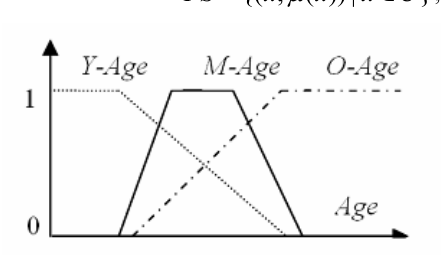
Table 1: Database ( D ) with Continuous Domains. Figure 1: Fuzzy Sets Y-Age , M-Age and O-Age